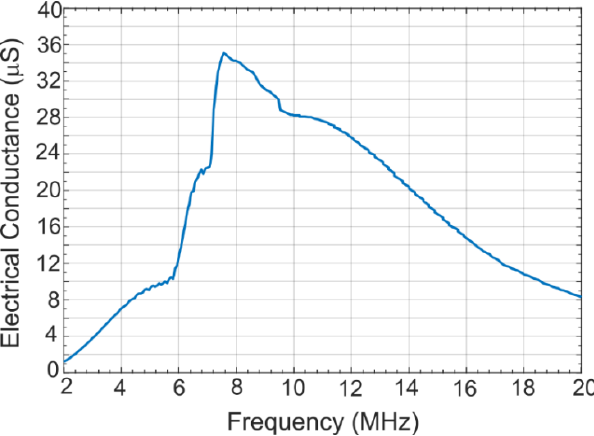
Figure 10. Frequency response of the excited element in an aerogel coated CMUT array [21].